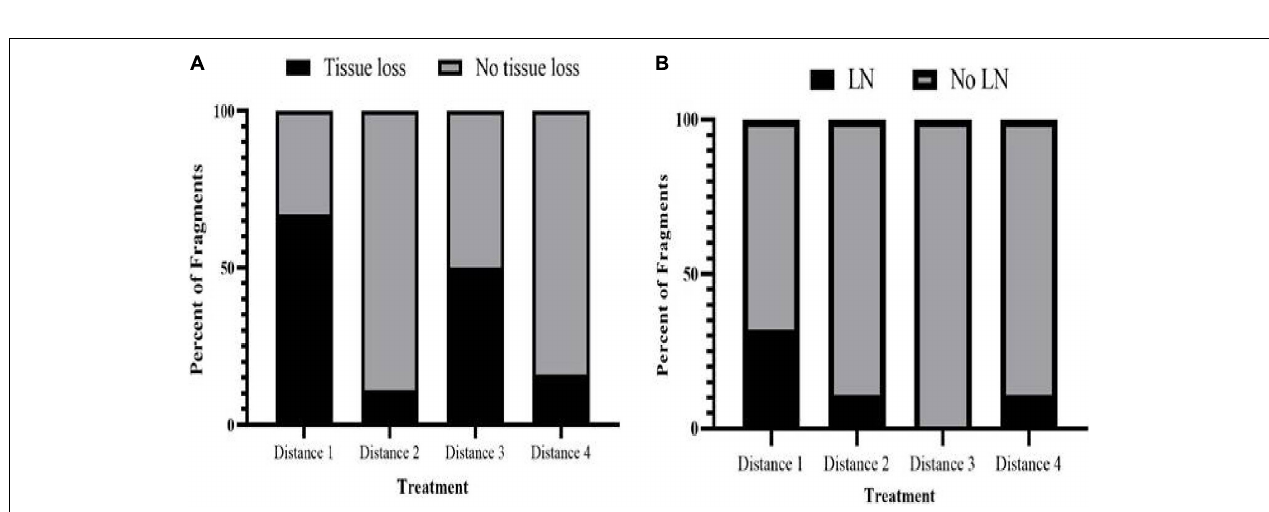
FIGURE 4 | Comparison of disease induction in M. cavernosa recipient fragments touching different M. cavernosa donors (D1, n = 12; D2, n = 9; D3, n = 6; D4, n = 6). (A) Percent of touching M. cavernosa recipient fragments showing gross signs of tissue loss when in contact with different donor M. cavernosa treatment fragments. (B) Percent of touching M. cavernosa recipient fragments showing a histopathological parameter, lytic necrosis (LN) when in contact with different donor M. cavernosa treatment fragments.